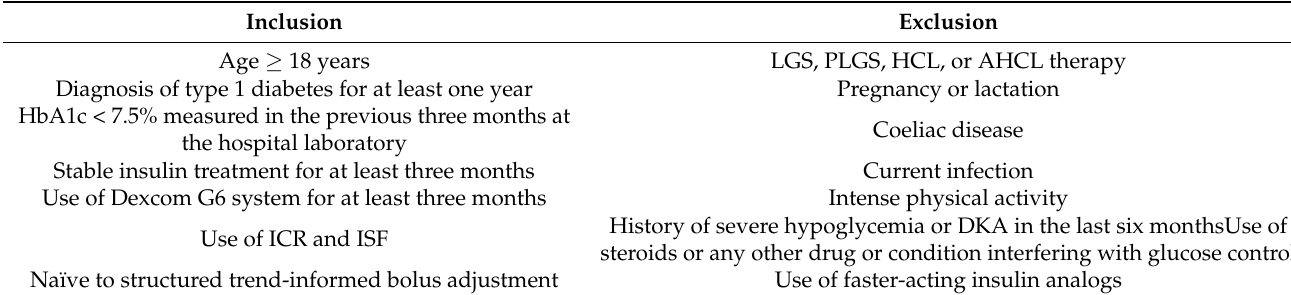
Table 1. Inclusion and exclusion